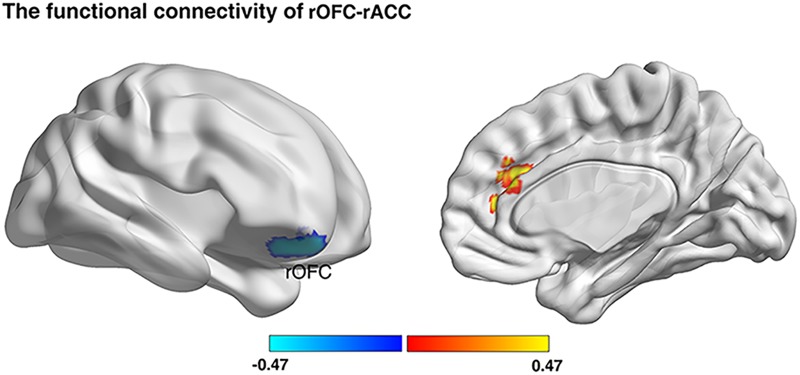
Resting-state functional connectivity result. We defined the rOFC and the rPPC bases on the VBM analyses, respectively, as masks. Functional connectivity between seed regions and rACC was positively correlated with gambling rates (p < 0.05; Alphasim corrected, cluster size >187).